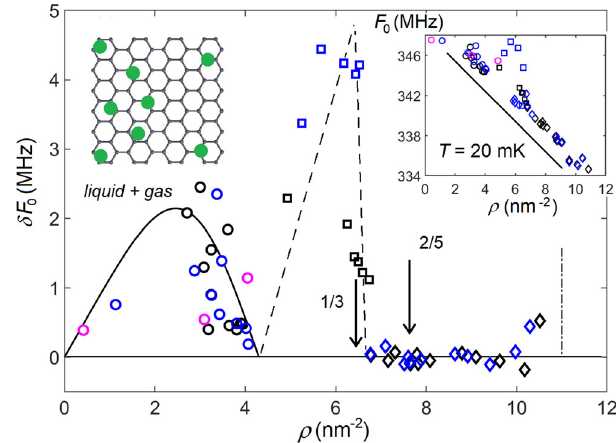
Fig.2|Overallphasediagramof 3 Hesub-monolayeronacarbonnanotube. The individualpointson the phase diagram wereobtained from F 0 ( T ) traces illustrated inFig.1.Circles:transitionsfromthephase-separatedclusteredliquid+gassystem to uniform fl uid;opensquares:transitions from the mixture1/3solid plus liquidto uniform fl uid;diamonds:transitionfromthegliding2/5solidto fl uidbelow8.2nm − 2 and to high- T solid at larger coverages; fi lled squares: transition from the high- T solid to liquid. Different colors represent different mechanical resonances. The solid curve depicts the fi t of the van der Waals liquid-gas phase separation curve (see the Methods section for details). The transition occurs at temperature T c ( ρ ) wheretheline ρ =const ð T Þ crossesthephaseseparationcurve,seetheinsertonthe bottom left. Two other inserts and vertical arrows show the coverages and struc- tures of the 1/3 and 2/5 commensurate solids on